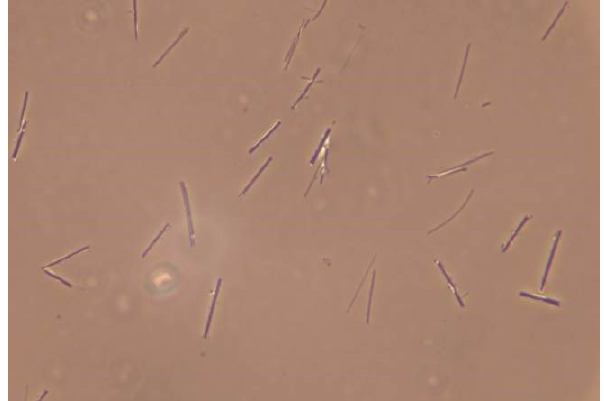
Fig. 2. Example photograph of the classified glass fibres